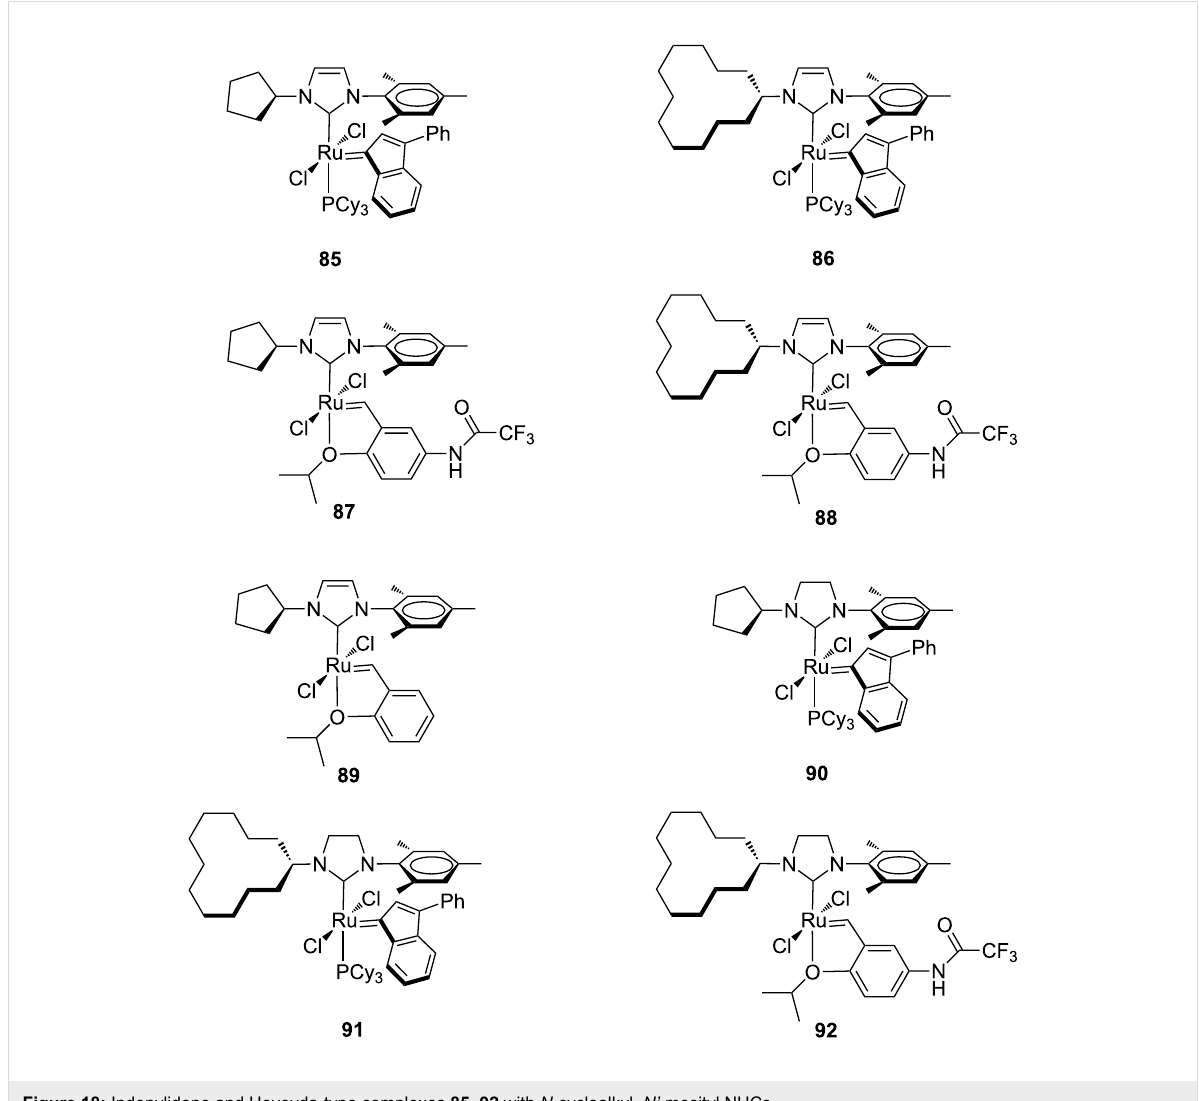
Figure 18: Indenylidene and Hoveyda-type complexes 85 – 92 with N -cycloalkyl, N’ -mesityl NHCs.